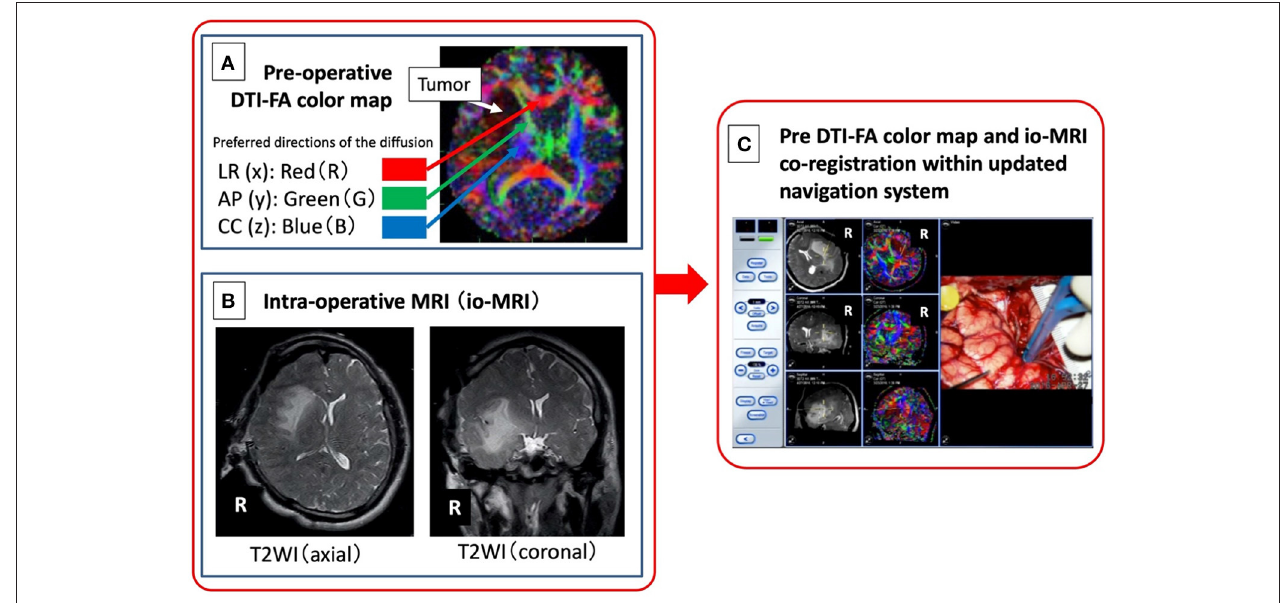
FIGURE 1 | Image integration of pre-operative DTI-FA color map (A) and intraoperative MRI (B) navigation system. A newly developed system (C) in which an FA color map, as an objective measure of neural function, from pre-operative DTI is combined with intraoperative MRI image obtained after craniotomy, is